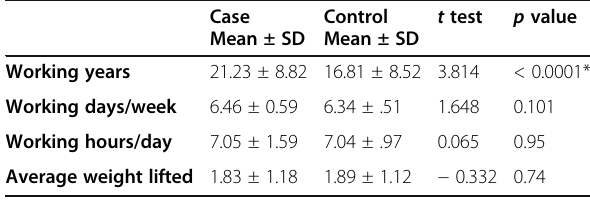
Table 2 Comparison between cases of retinal detachment and controls regarding occupational data